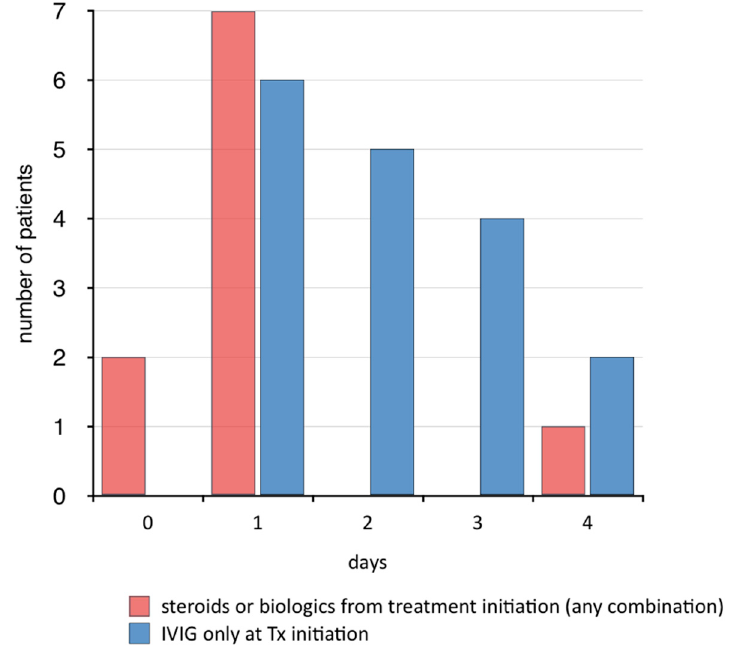
Figure 7. Time from decision to treat to defervescence in days, by treatment regimen, illustrating significantly more rapid achievement of patients becoming afebrile if steroids were included at treatment initiation.